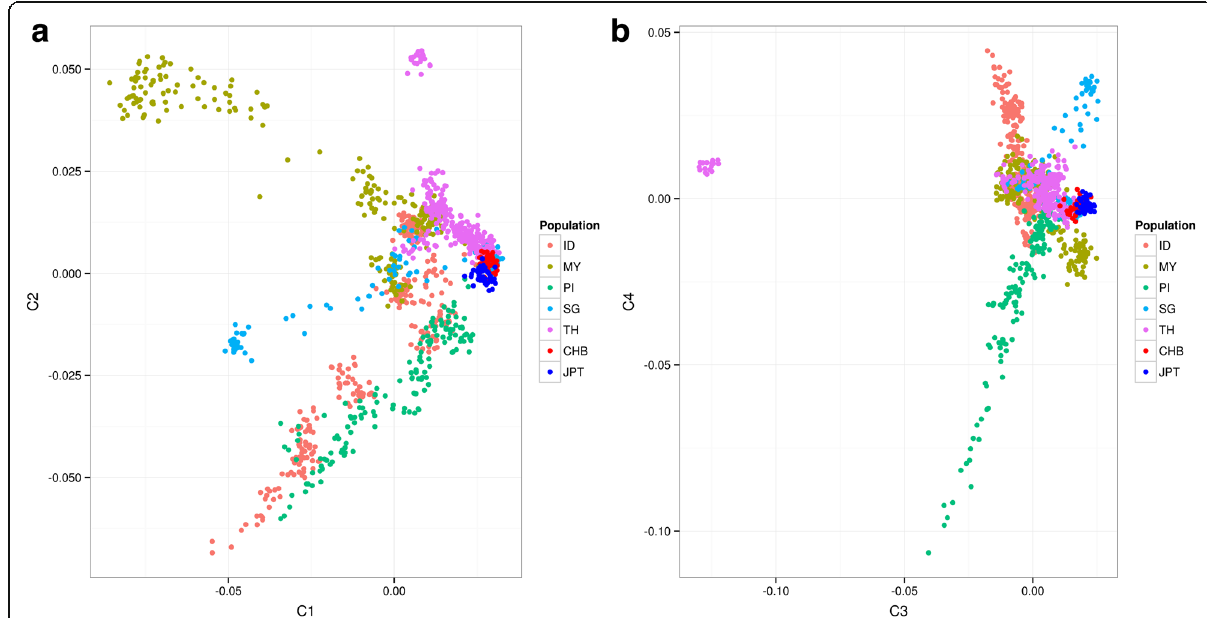
Fig. 3 Multidimensional scaling plot of Southeast Asian populations from PanSNPdb. Genotype data of samples from Southeast Asian populations were downloaded from PanSNPdb. After quality control, multidimensional scaling (MDS) was performed in PLINK v1.07. a Plotting of the first (C1) and the second (C2) axes. b Plotting of the third (C3) and the fourth (C4) axes. Abbreviations: Indonesia (ID), Malaysia (MY), the Philippines (PI), Singapore (SG), Thailand (TH), China (CHB) and Japan (JPT)